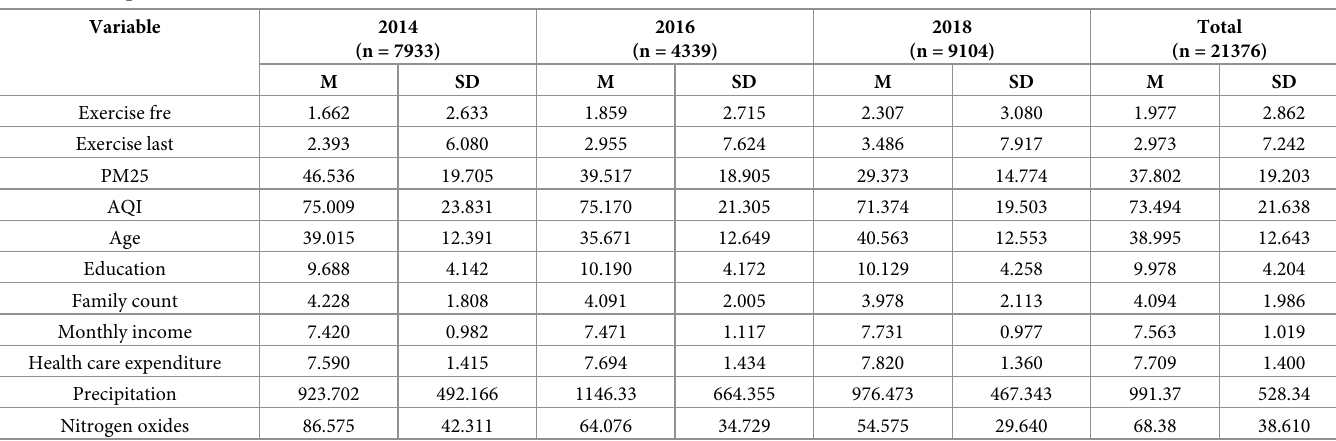
Table 2. Descriptive statistics of continuous variables.